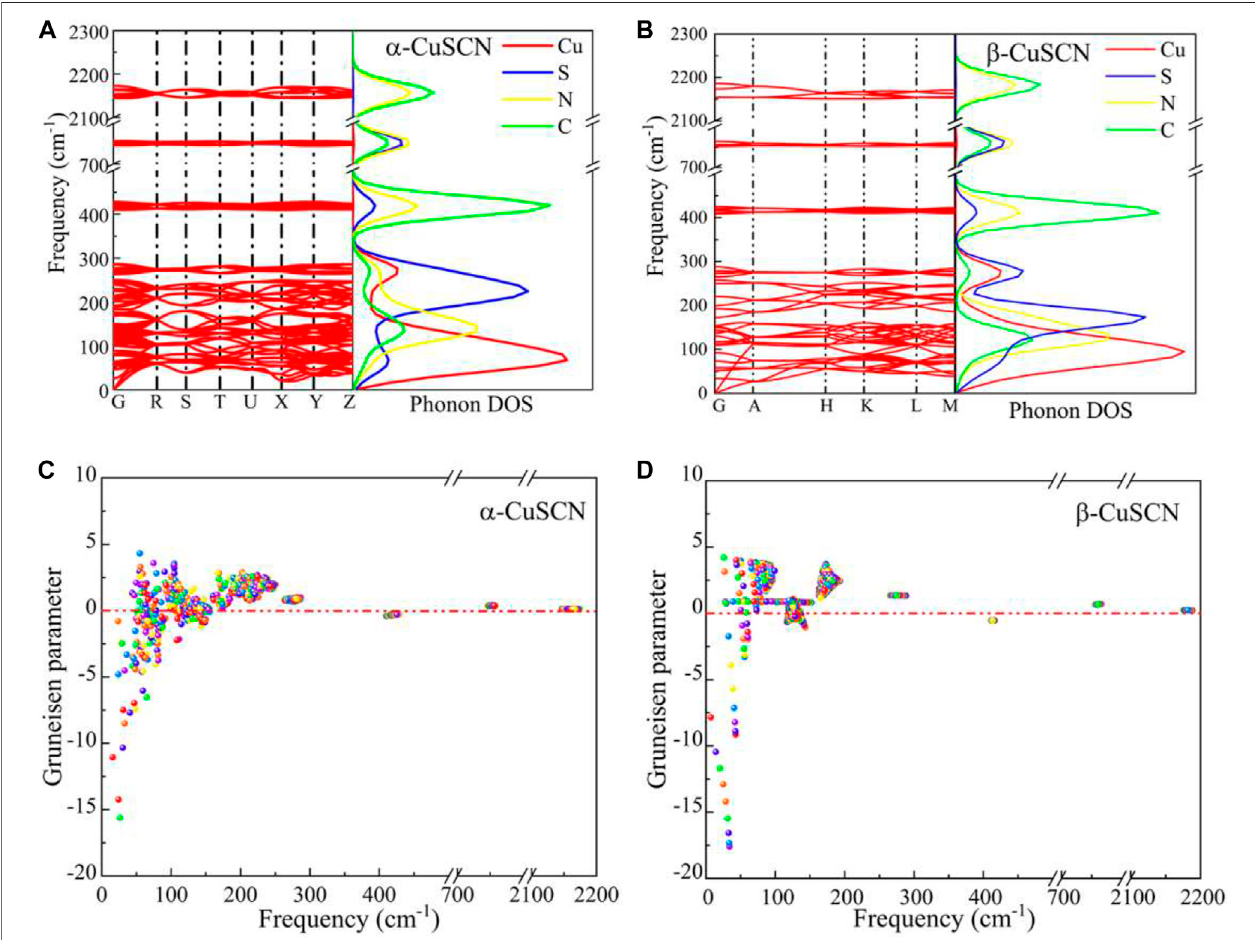
FIGURE 2 | Phonon dispersion and PDOS for (A) α -CuSCN and (B) β -CuSCN. The mode Grüneisen parameters as a function of vibrational frequency for (C) α -CuSCN and (D) β -CuSCN.